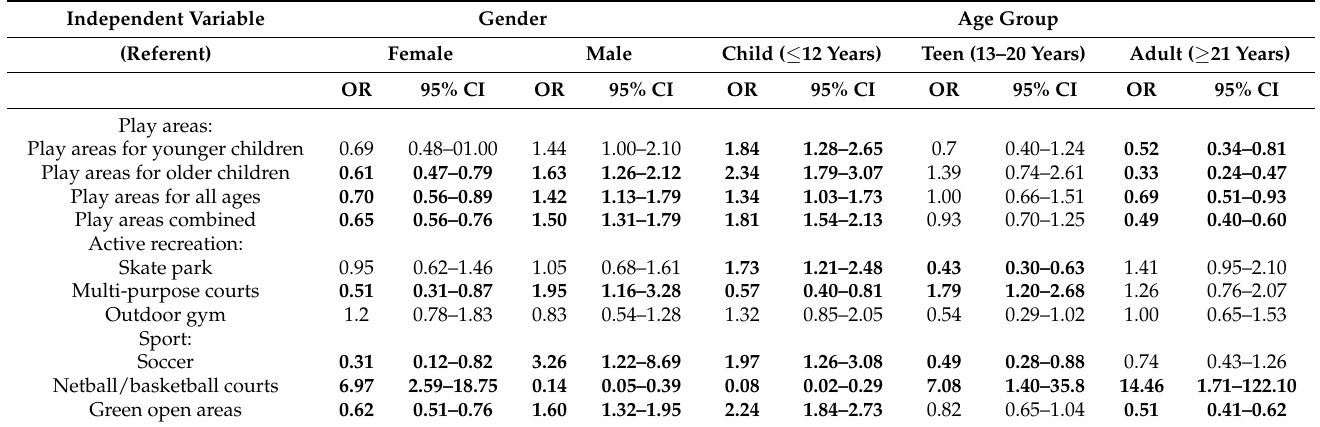
Table 9. Association between target area features and park-based physical activity (PA) by demo- graphic